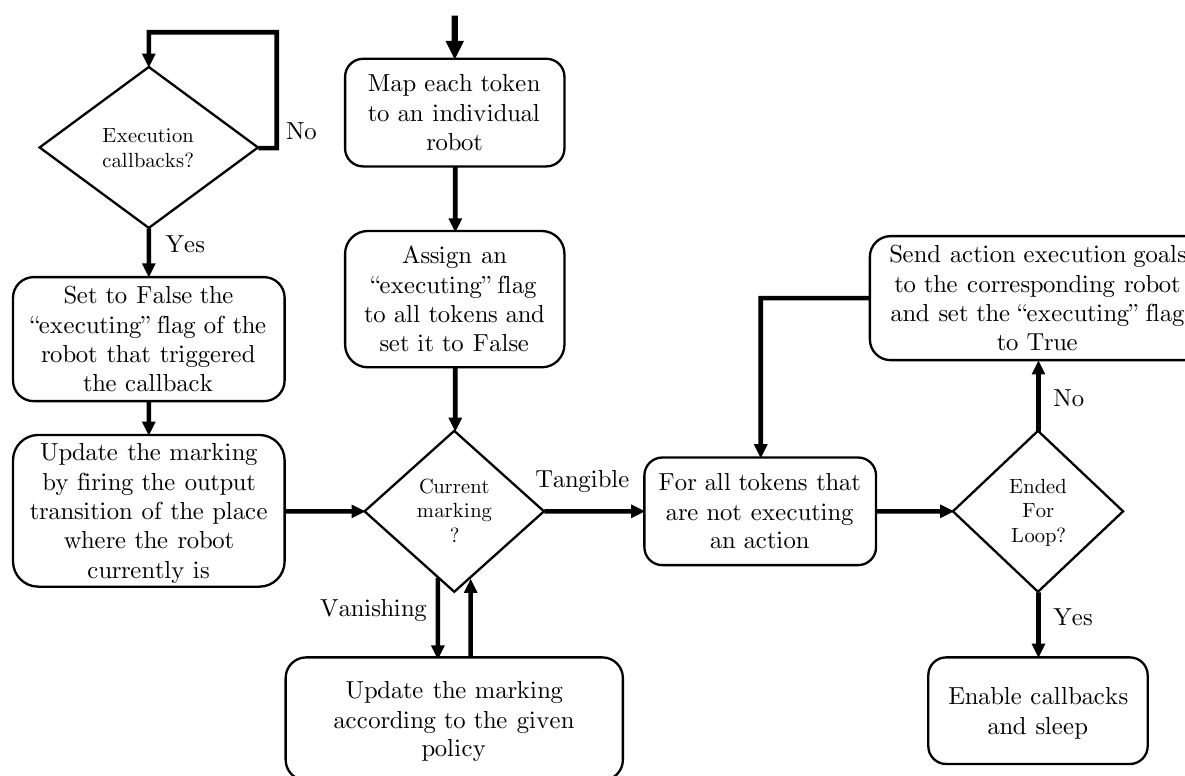
Figure 7. Execution manager algorithm